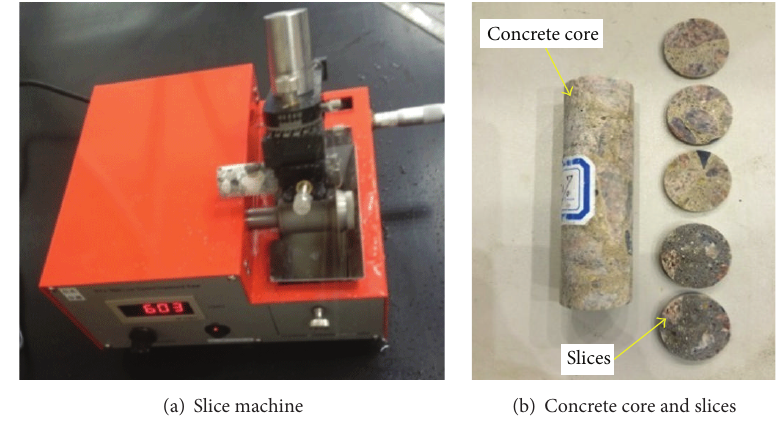
Figure 6: Slice machine and the samples.